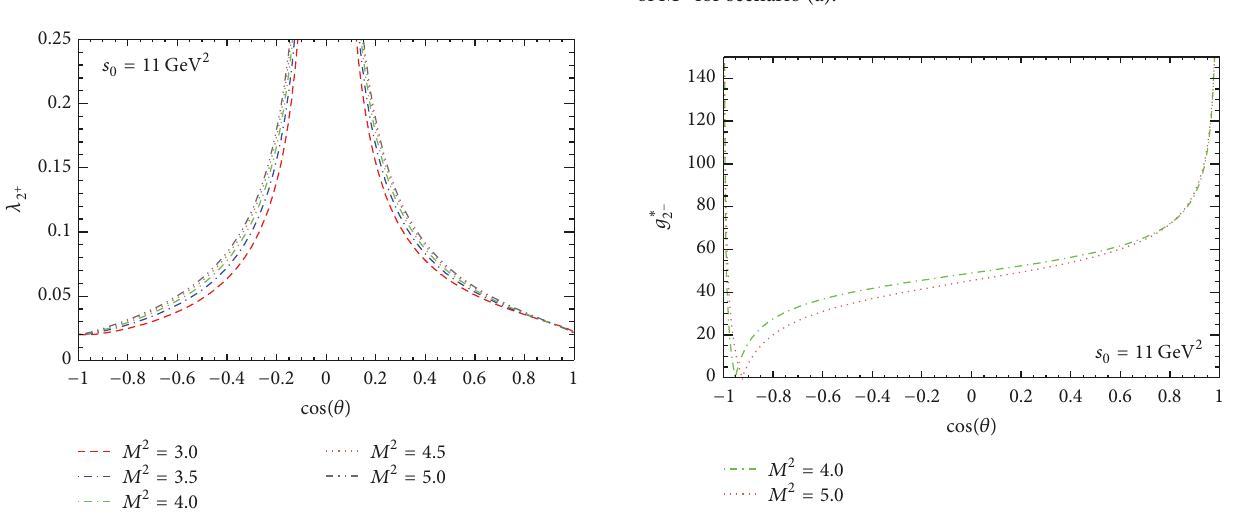
Figure 3: Same as in Figure 1, but for scenario (b).